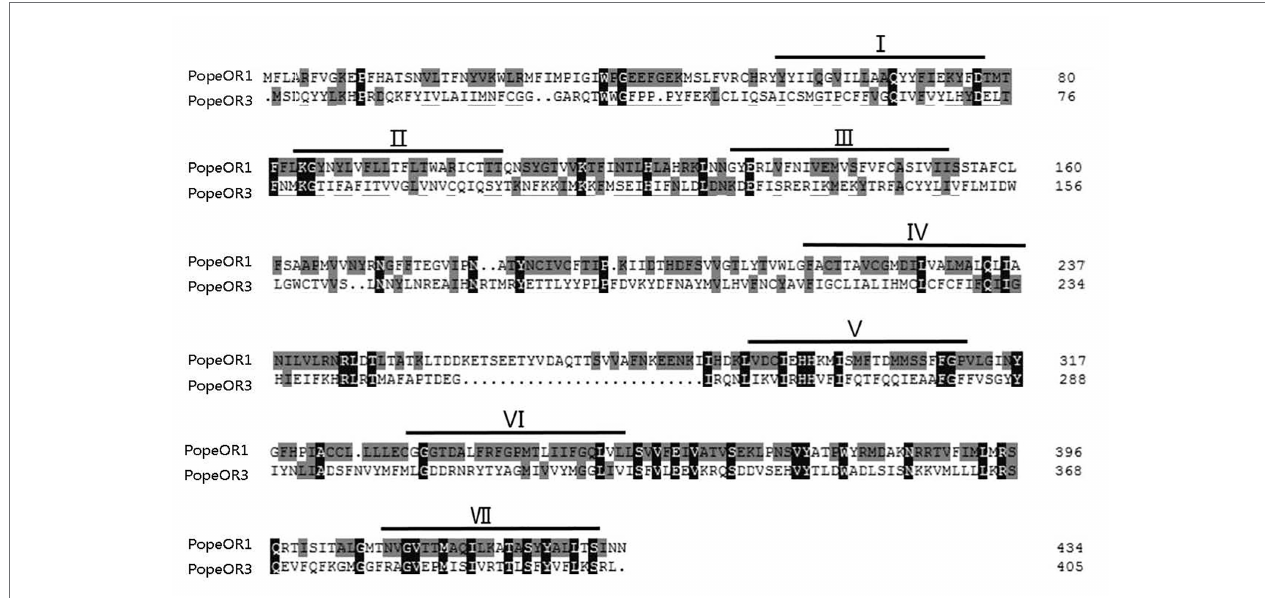
FIGURE 1 | Alignment of the amino acid sequences of the two candidate PRs in Phthorimaea operculella . Identical amino acids are marked with gray and black shading. Predicted seven transmembrane domains (TMD1-TMD7) are indicated by bold